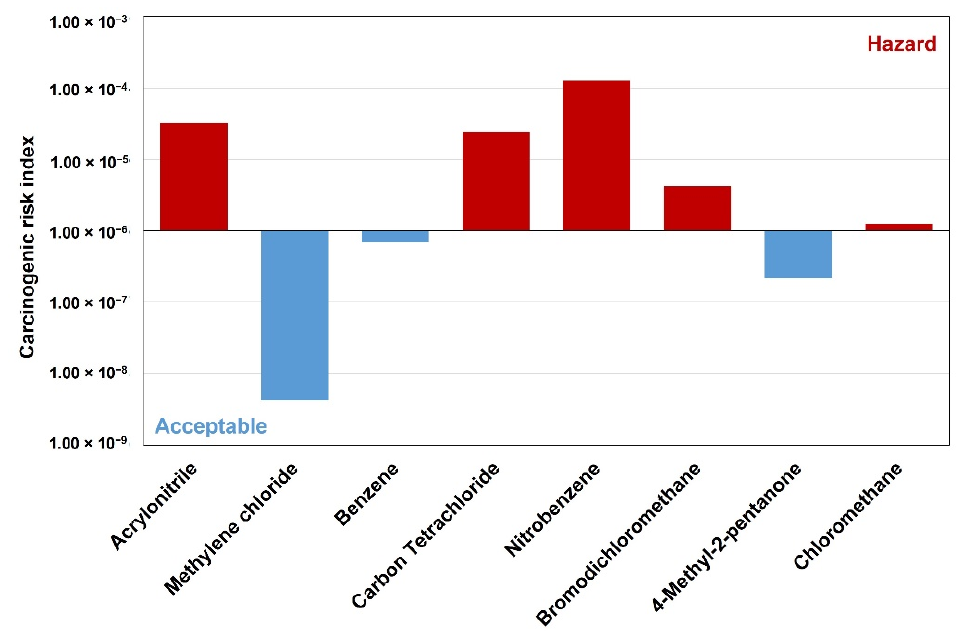
Figure 5. Risk assessment result of toxic carcinogenic VOCs.